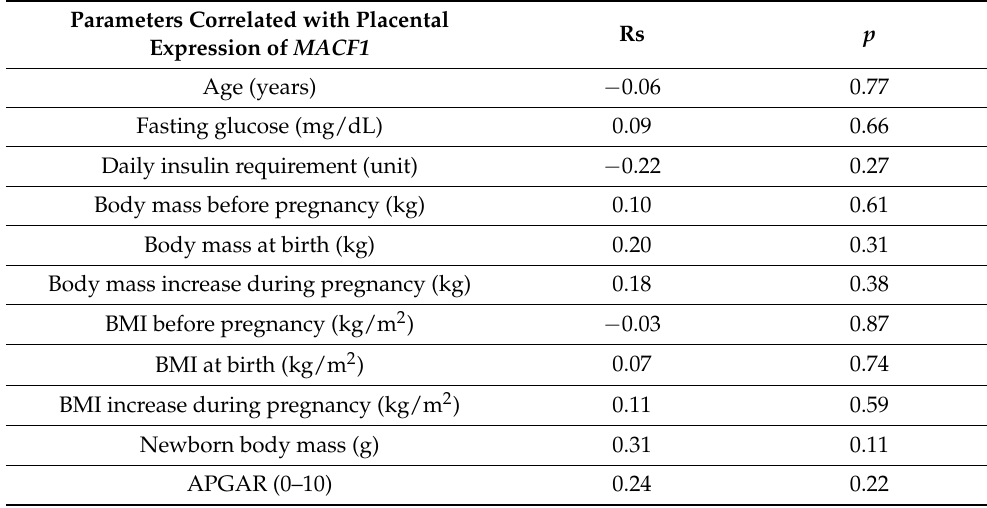
Table 7. Correlations between MACF1 expression in the placenta and clinical parameters in the GDM group [21–23].